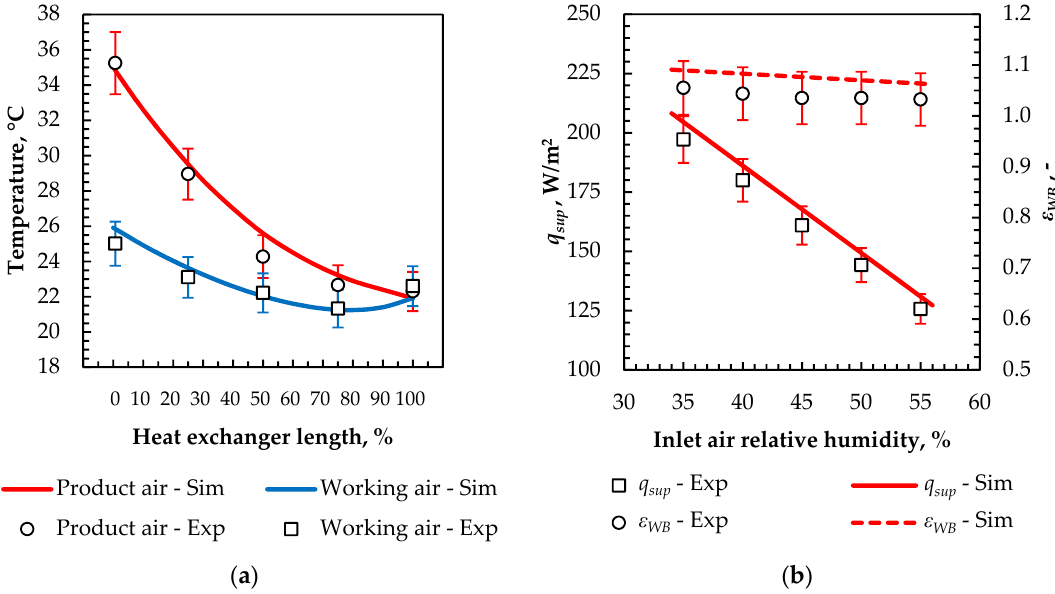
Figure 6. Comparison of the simulation output with the experimental data for an integrated heat pipe and porous ceramic cuboid-based indirect evaporative cooler (IEC2) [33]: ( a ) Product and working air temperature distribution for inlet conditions 35 °C and RH 35%; ( b ) Impact of inlet air relative humidity on cooling capacity and wet bulb effectiveness (35 °C).